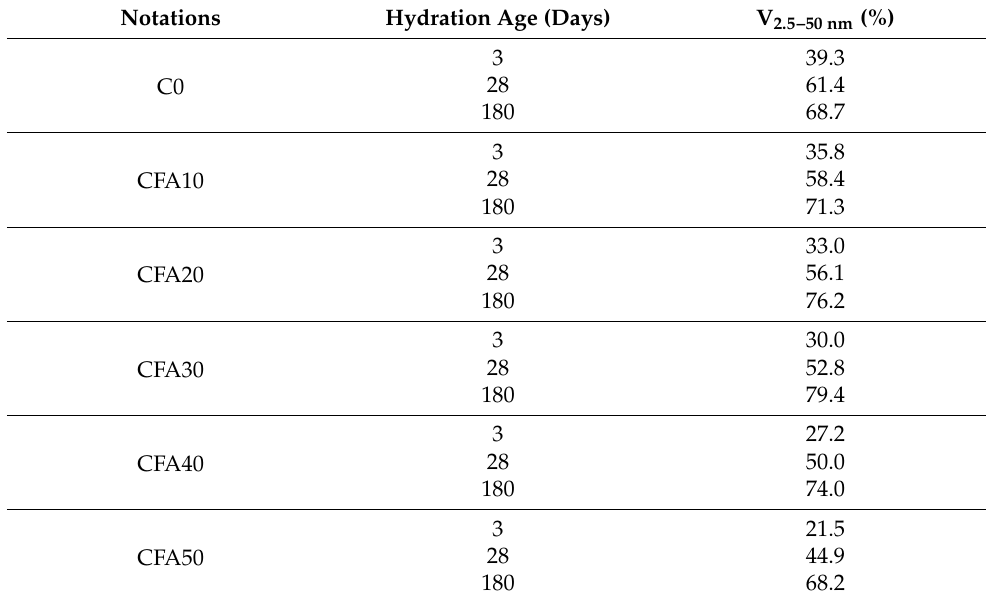
Table 6. V 2.5–50 nm of the face slab concretes containing fly ash at different